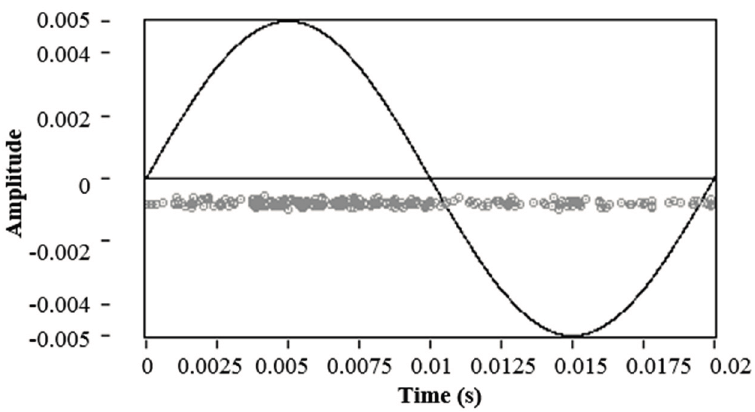
Figure 5. PRPD for noise acquisition in the point-plane experimental test